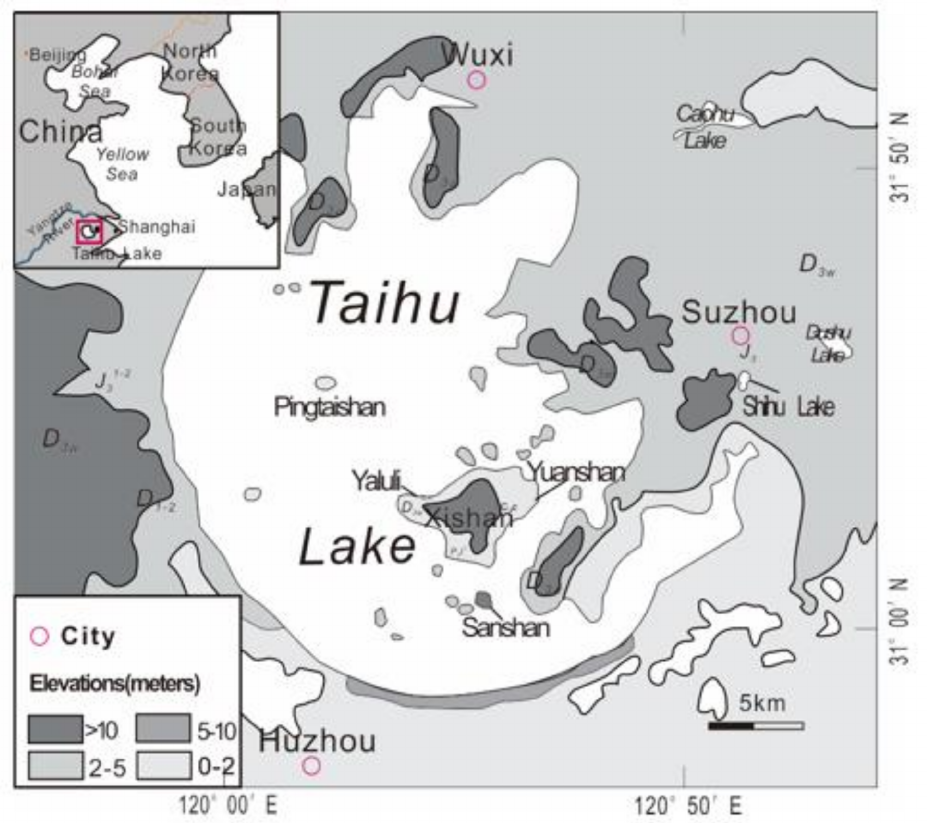
Figure 1. Simple sketch of geological map of Taihu Lake area showing sampling sites. White area is lake water, light gray is local plain and dark gray is hilly region. Small map inserted in upper left corner showing Taihu Lake on a regional